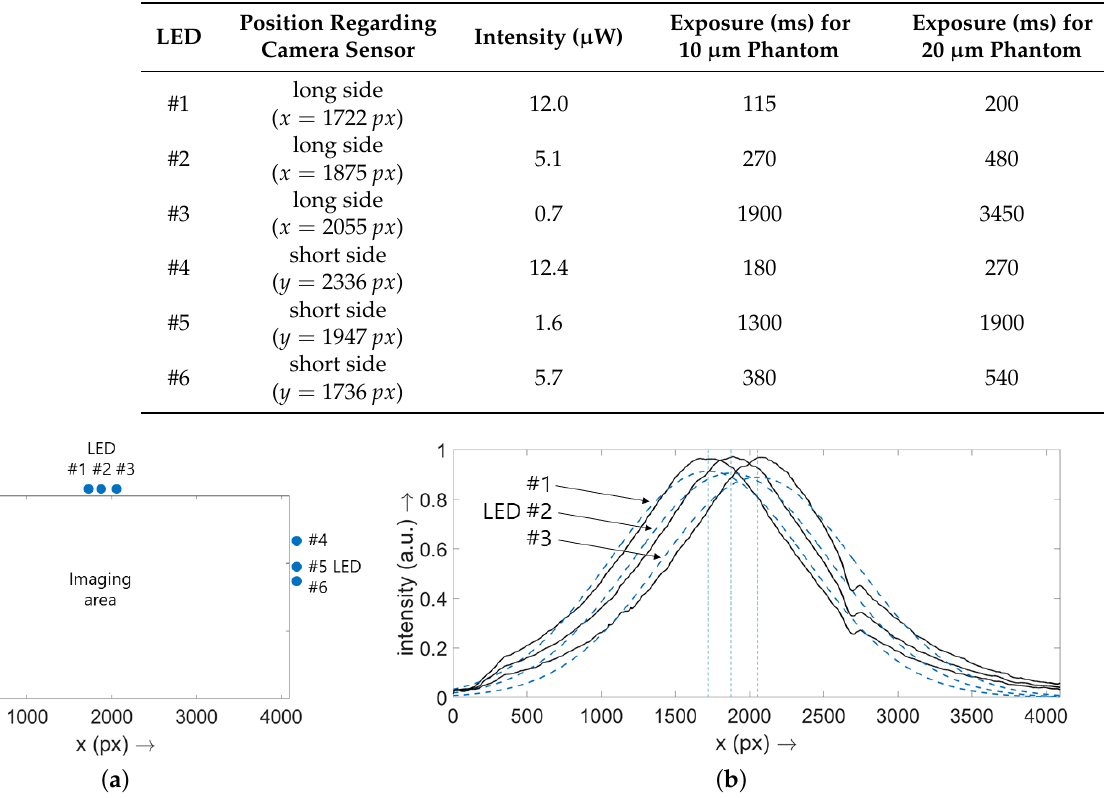
Figure 2. ( a ) Sketch to visualize the location of the imaging area of the SP-DRI sensor and the single LEDs (numerical values are given in Table 1). The view taken here is from the direction of the camera (in contrast to Figure 1f). To achieve a joint origin of both axes of the plot, the y-axis was flipped. This format was also chosen for the results section of this study. Note: Only six LEDs are shown because, as described, one LED per illumination block is kept as backup. ( b ) Exposure situation for the three LEDs running along the x axis for the phantom with a thread diameter of 10µm. The single curves (black) were generated one after the other by placing the sensor on the phantom and turning on the respective LED. A cross-sectional plane at y = 3000 px through the recorded diffuse reflectance image was then taken. The Gaussian curves fitted to the raw data are shown as blue dashed lines ( R 2 > 0.96 for all cases), the maxima of which were interpreted as the x positions of the LEDs. The procedure for the LEDs aligned along the y axis was identical. As expected, the same values resulted for the second phantom. Note: ( b ) is scaled to